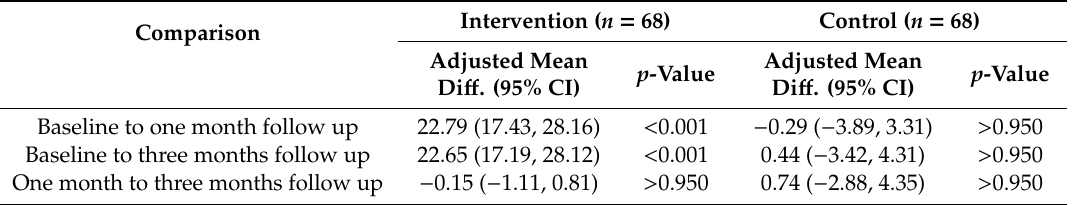
Table 3. Comparison for mean di ff erence of M-DCSD knowledge score within each group (time e ff ect), using the Intention to Treat (ITT) approach ( n =